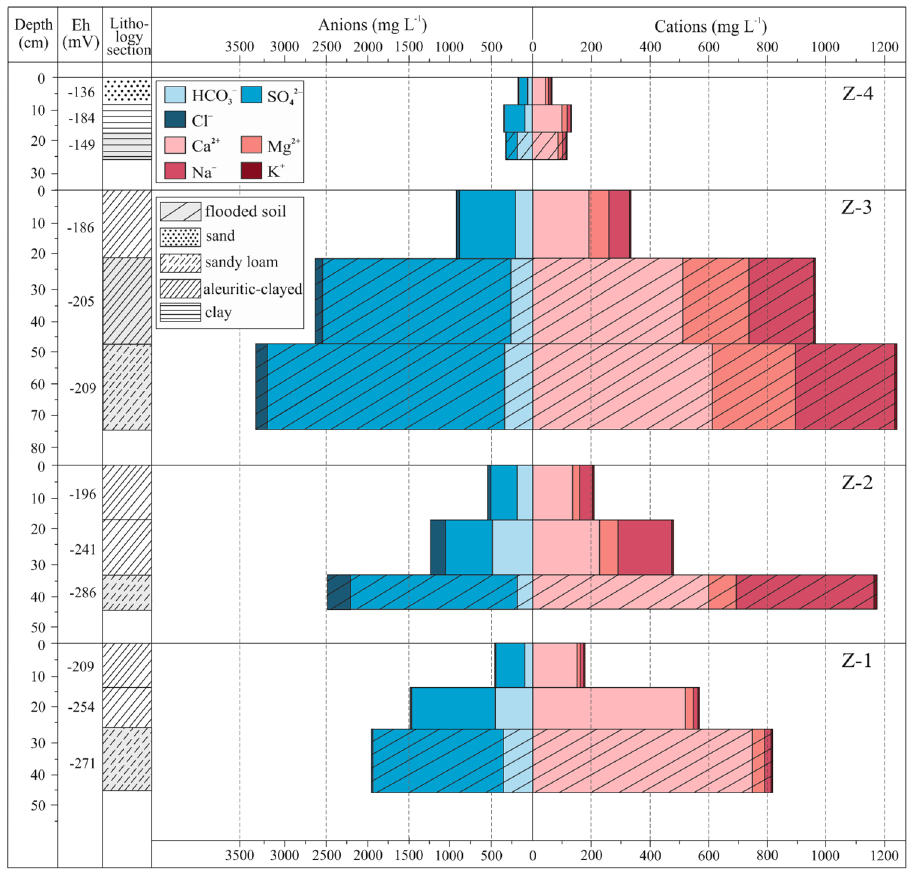
Figure 4. Major ion distributions in pore waters from entry to bays, Bratsk reservoir. Figure was created using CorelDRAW (21.3.0.755, www. corel.